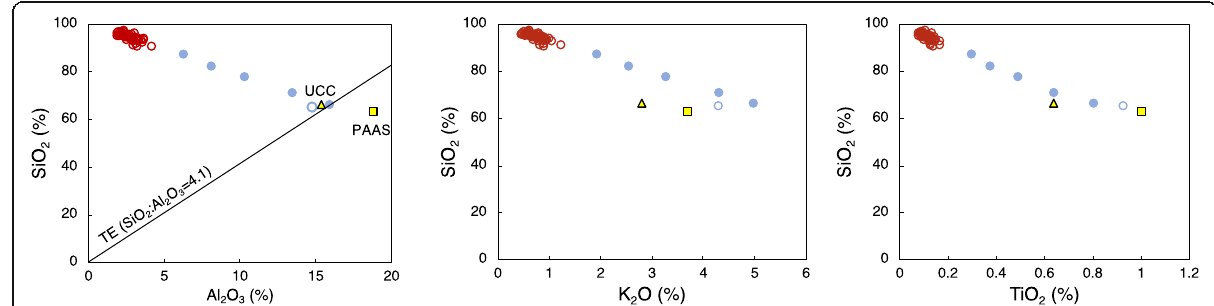
Fig. 4 Plots of SiO 2 vs. Al 2 O 3 , K 2 O, and TiO 2 for the chert and claystone samples. Chert (red open circles) and lower (blue open circles) and upper (blue filled circles) claystone samples exhibit negative correlations, indicating dilution with biogenic silica (e.g., radiolarians). TE terrigenous material in the